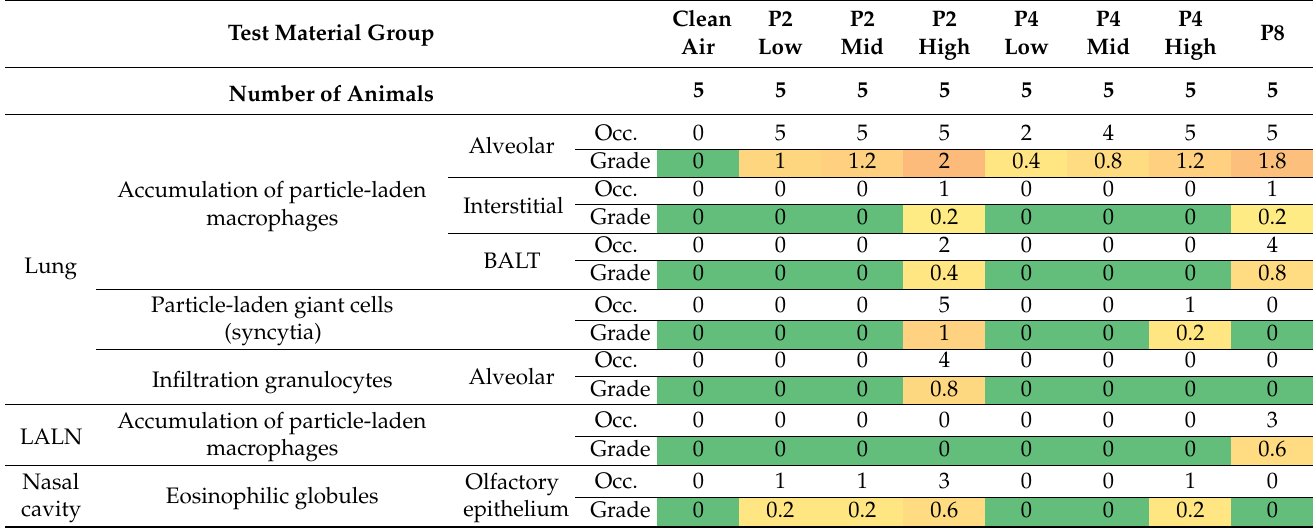
Table 4. GRNP-related histopathological findings at day 29